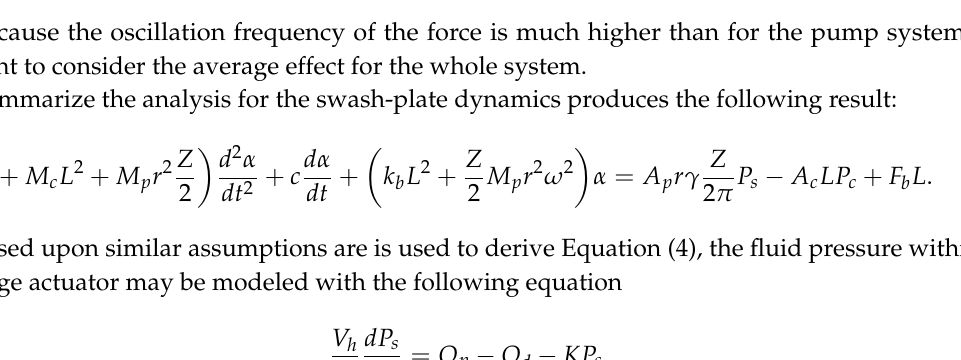
Figure 3. Pressure profile for illustrating the essential characteristics of delivery